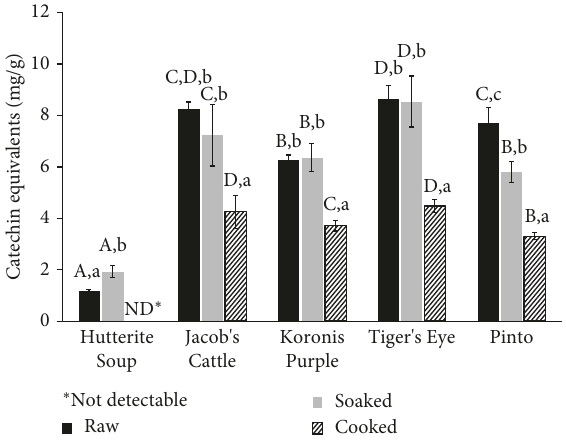
Figure 4: Total flavonoids content of raw, soaked, and cooked